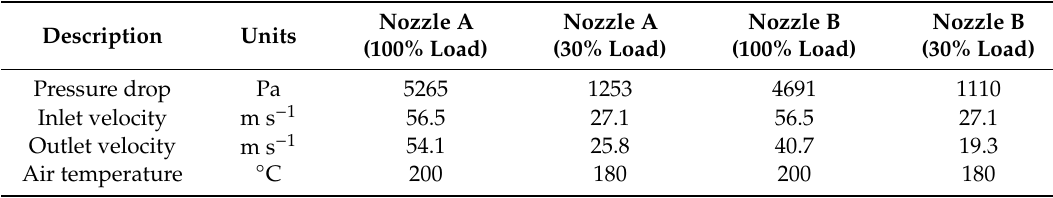
Figure 8. Computational fluid dynamics ( CFD) and cold-state experimental results of nozzle A and nozzle B. Table 3. Comparison of operating results.